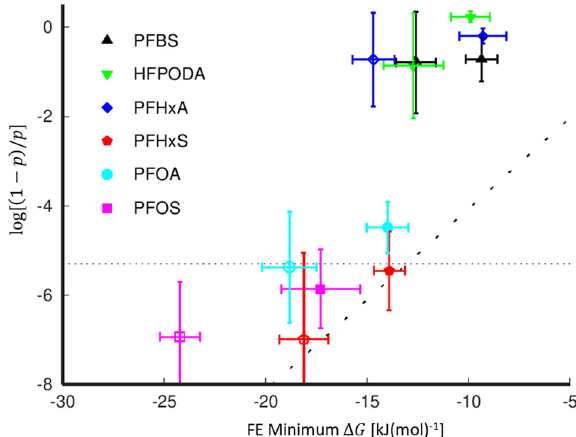
Fig. 4 Comparison of experimental and computational results. The experimental fi ltration ef fi ciency represented as log 1 (cid:2) p the simulated FE minimum value Δ G . Experimental data for the 100 ppt dynamic fi ltration experiment are shown. Results for F16- 4PEG are shown as open symbols while H16-4PEG results are closed symbols. Error bars represent the standard deviation of results from two independent experiments and the standard deviation of Δ G values from fi ve independent metadynamics simulations.